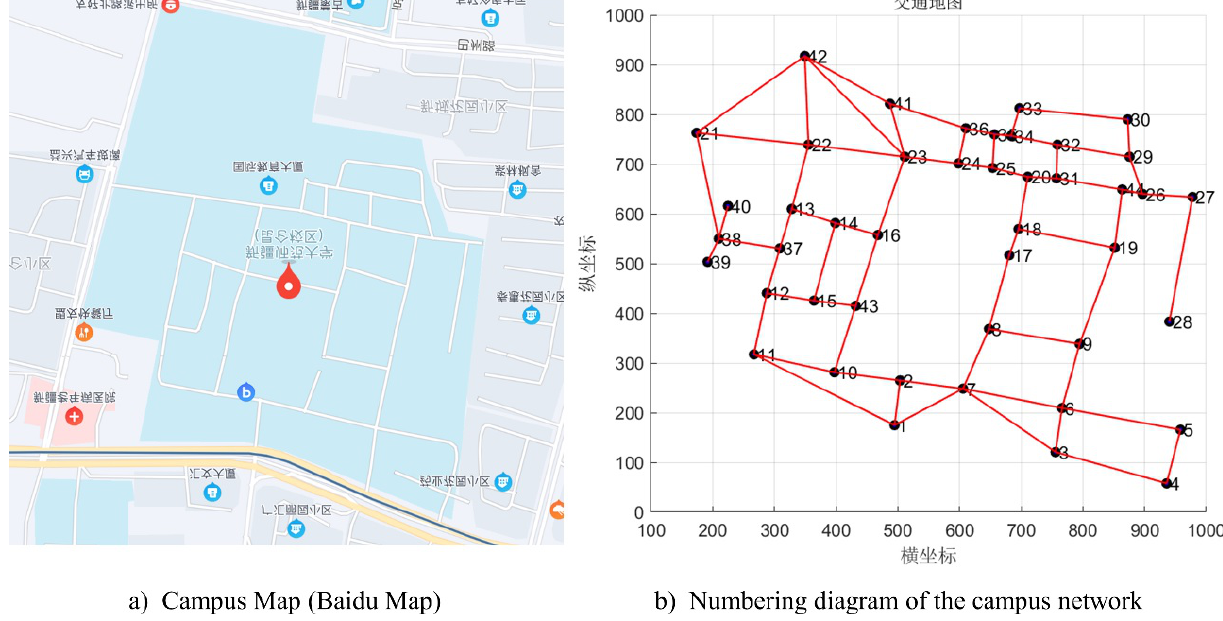
Fig. 1 Campus map and campus